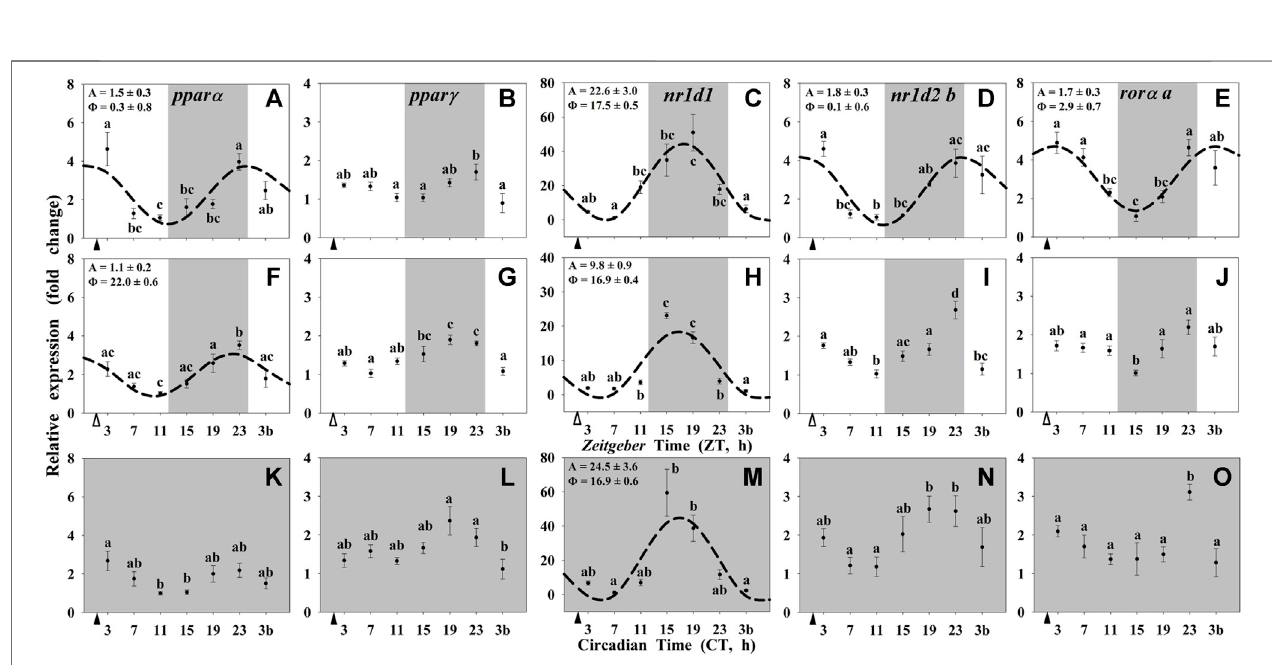
FIGURE 4 | Daily pro fi le of NRs transcripts in the liver of gold fi sh maintained under different lighting conditions and feeding protocols. Grey area indicates the dark period.Feedingtimeisindicatedbytrianglesinthex-axis(solid, ▲ ,scheduledfeedingatZT/CT2;white, Δ ,randomfeedingwiththelastmealatZT2).Dataareshownas mean ± SEM (n = 5 – 7) in relative units (2 − ΔΔ Ct method). Different letters indicate signi fi cant differences (ANOVA p < 0.05, SNK post hoc test). When Cosinor ( SE(A)/A < 0.3 ) was signi fi cant and A > 1 , periodic sinusoidal functions were represented as dashed curves with the corresponding amplitudes and acrophases ( A and Φ ,